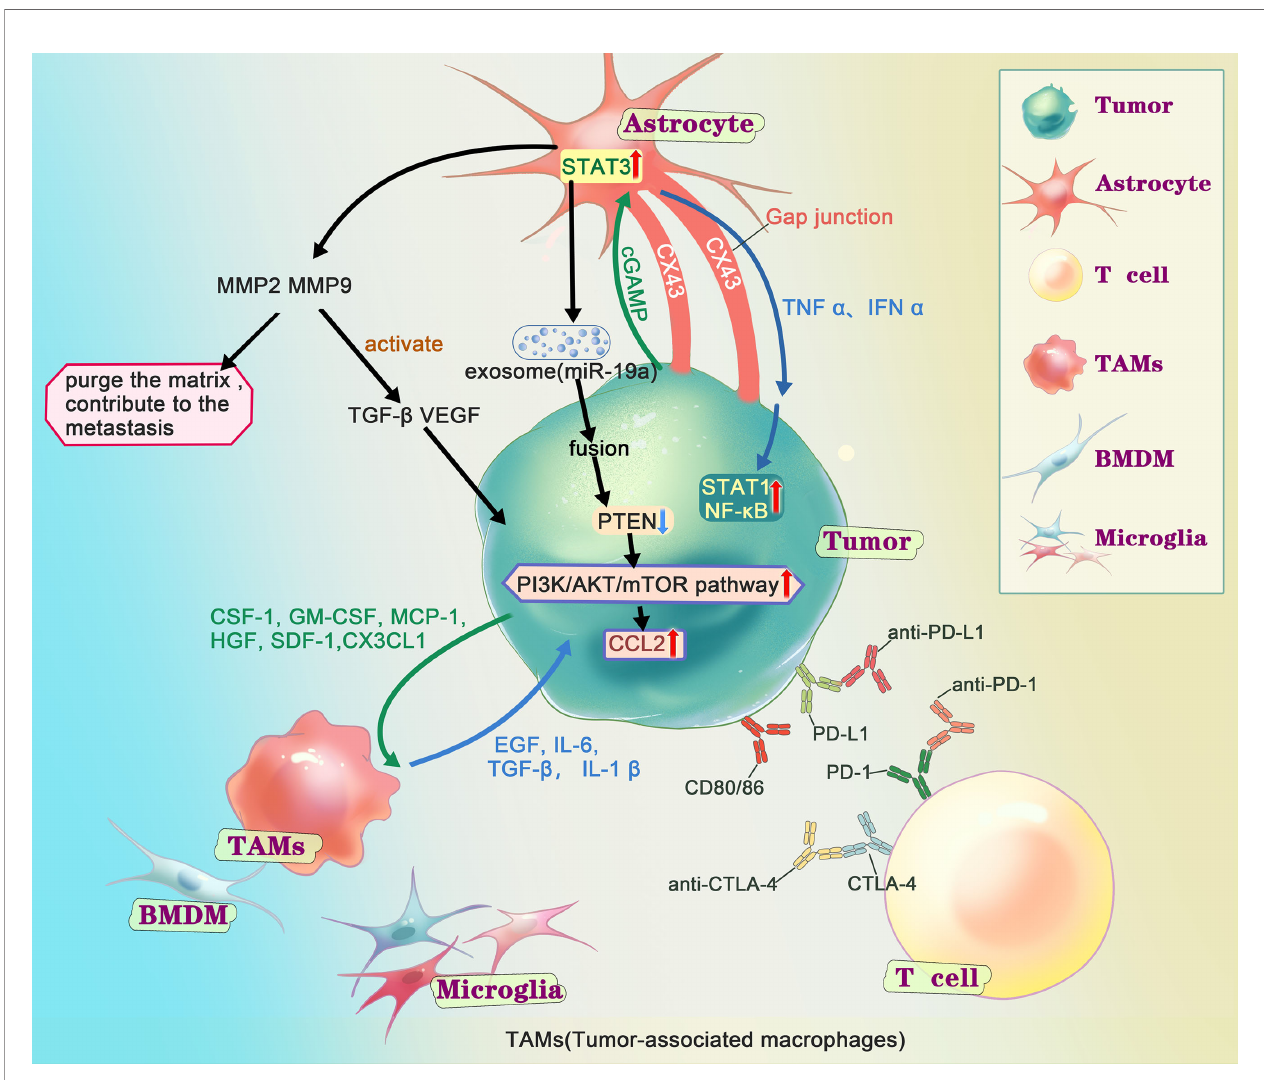
FIGURE 2 | Interactions of metastatic tumor cells with the brain microenvironment. After the tumor cells get into the CNS (central nervous system), according to the “ seed and soil ” , series of interactions happened between the tumor cells and the microenvironment in brain. Extensive research has shown that astrocytes play an important role in metastasis through matrix metalloproteinase 2 (MMP2), MMP9, exosome and gap junction, generally supports the growth and invasion. MMP2 、 MMP9 are associated with tumor growth. On the one hand, it could degrade components of the extracellular matrix and basement membrane, on the other hand, it helps to activate TGF- b and VEGF. Several studies have shown that after fusion of AST-generating exosomes with tumor cells, miRNAs contained in the exosomes cause tumor cells to under-express PTEN and further activate the PI3K/AKT/mTOR pathway, leading to more chemokine ligand 2(CCL2), promoting the growth of tumor. There are gap junctions composed of connexin 43 (Cx43) between tumor cell and astrocyte. Through the gap junction, astrocyte release cytokines such as IFN a and TNF a , activating STAT1 and NF- k B pathways, supporting tumor growth. At the same time, tumor cell could transfer cGAMP to astrocytes, activate the STAT3 pathways. Tumor-associated macrophages and microglia (TAMs), including bone marrow-derived macrophages (BMDMs) and microglia (MG), secret growth factors (EGF, IL6, TGF- b , IL-1 b ), contribute to the colonization. And the tumor cells release chemokines and cytokines (CSF-1, GM-CSF, MCP-1, HGF, SDF-1, CX3CL) to recruit TAMs towards the tumor cells. There are immune checkpoints expressed on T-cells, such as PD-1 and CTLA-4, which tumor cells could bind and deactivate T-cells, suppressing anti-tumor immunity. Checkpoint immunotherapy use antibodies to inhibit immune checkpoint to prevent the T-cell from deactivation and control the